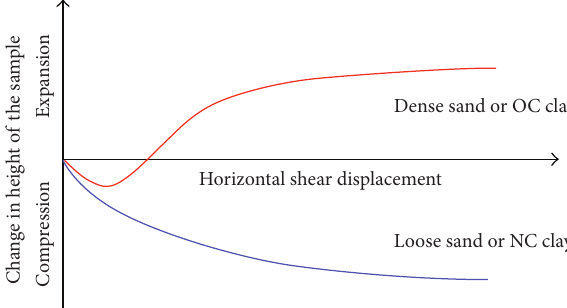
F 2: Typical vertical displacement versus horizontal shear displacement (OC stands for overconsolidated and NC stands for normally consolidated).